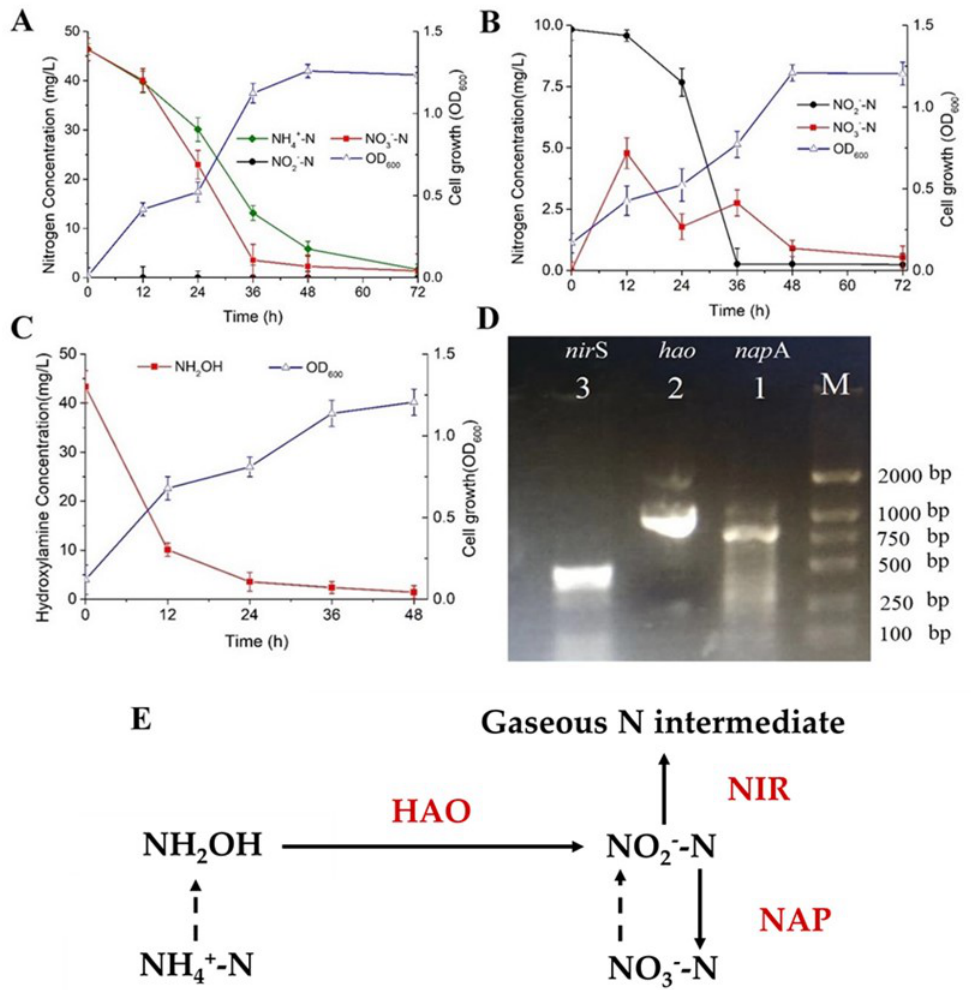
Figure 4. Cell growth and nitrogen removal characterization of strain F19, and demonstration of simultaneous heterotrophic nitrification and aerobic denitrification. ( A ) Nitrification ability of F19 in ammonium nitrate medium. ( B ) Denitrification ability of F19 in nitrite and ( C ) hydroxylamine medium. ( D ) PCR amplification of periplasmic nitrate reductase ( napA ), hydroxylamine oxidoreductase ( hao ), and nitrite reductase ( nir S) genes. ( E ) Predicted nitrogen utilization pathway in Janthinobacterium svalbardensis